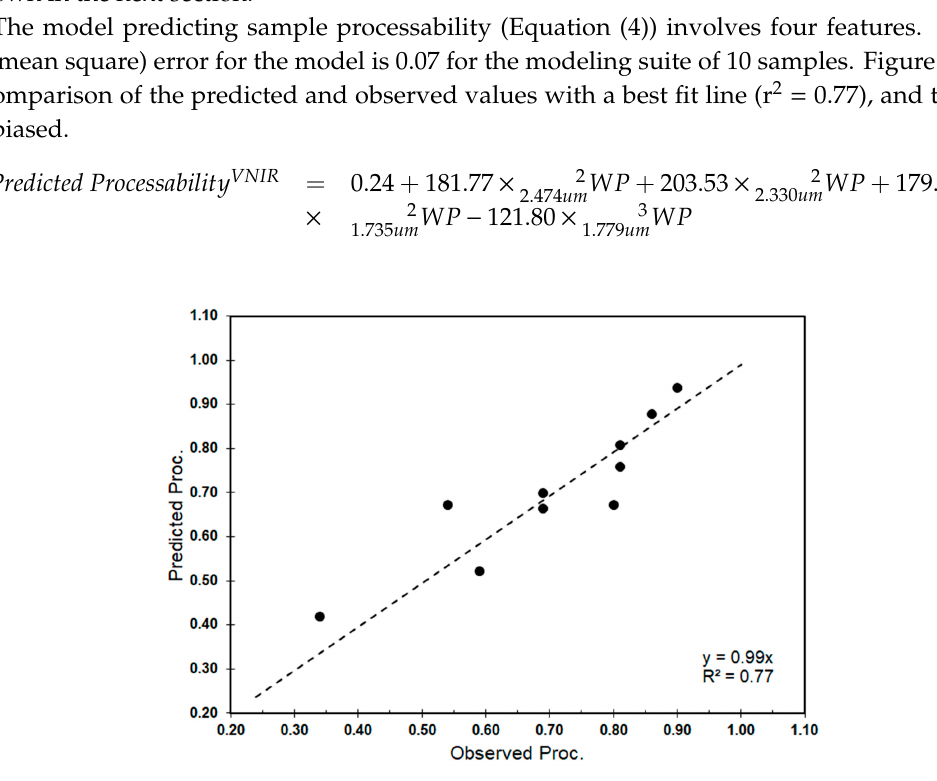
Figure 13. Scatter plot of the observed and predicted processability. The dashed line represents the trend